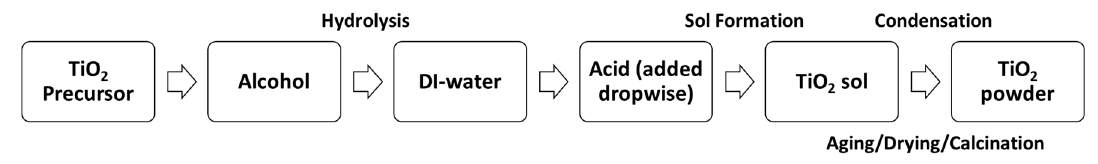
Figure 8. Sol–gel method for the preparation of bare and doped TiO 2 -based photocatalysts.